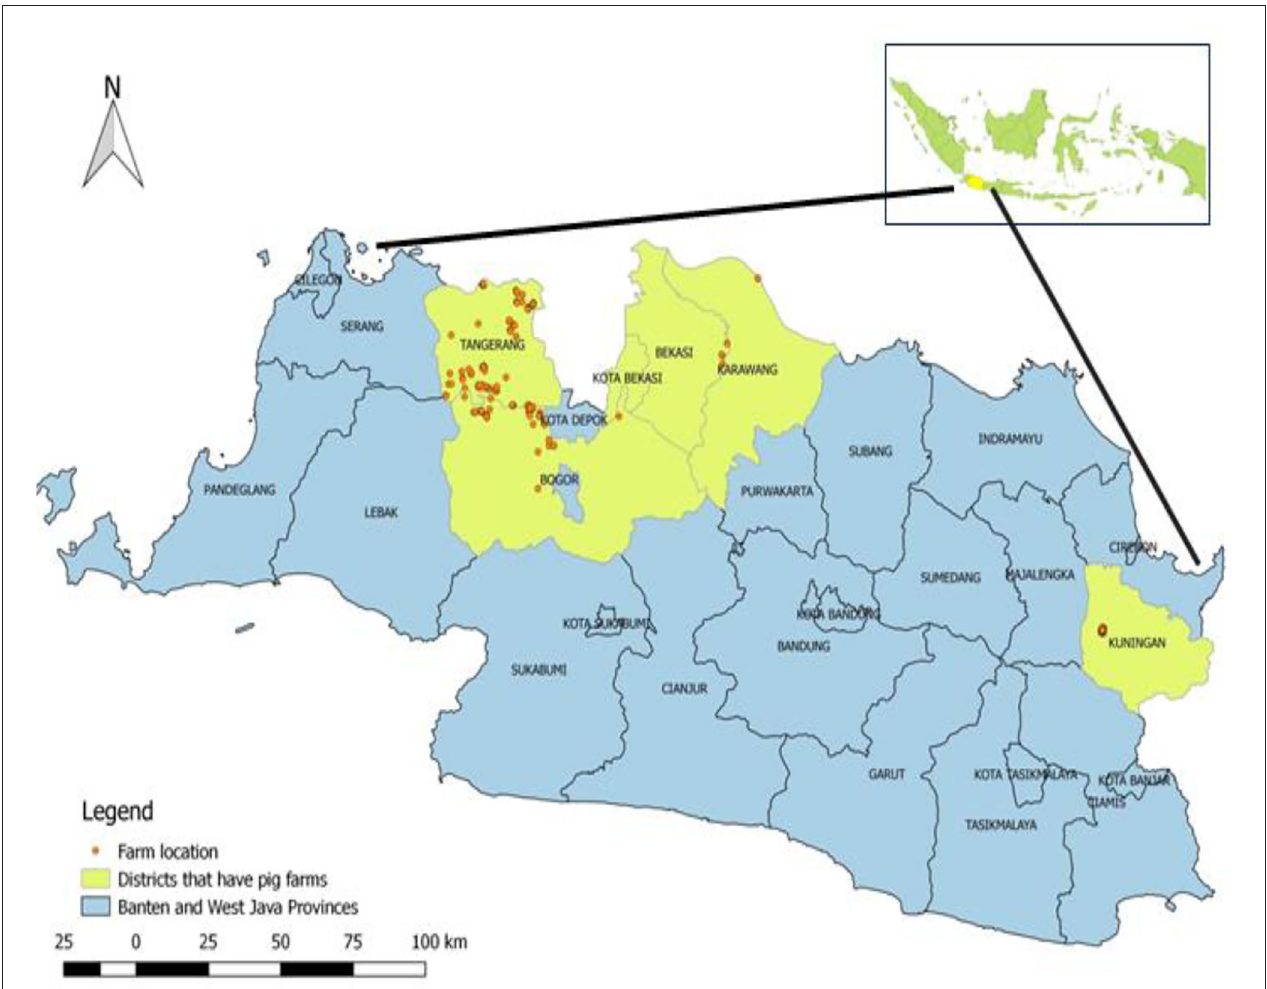
FIGURE 1 | Geographical map of the Republic of Indonesia and the study area including Banten province (Tangerang City, Tangerang) and West Java (Bekasi, Bogor, Karawang, and Kuningan). Districts where enquiries were conducted are yellow in color, and farms are represented as red, round dots.